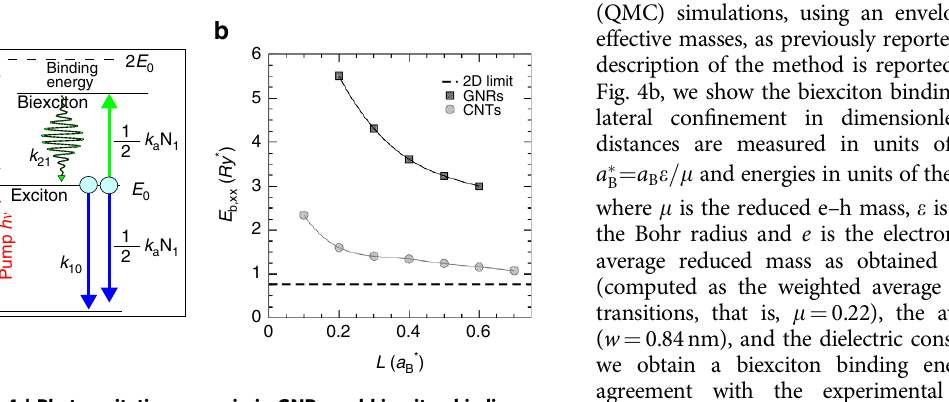
Figure 4 | Photoexcitation scenario in GNRs and biexciton binding energy. ( a ) Sketch of the energetic levels and the kinetic model described in the text. ( b ) Biexciton (XX) binding energy ( E b,XX ) as a function of the lateral dimension ( L ), that is, width for GNRs (black squares) and diameter for SWNTs (grey circles). The data, obtained by guide-function QMC simulations, are shown in dimensionless exciton units, as detailed in the text. In these units, the binding energy of the 4CNR is B 3.4 Ry *. The dashed line indicates the two-dimensional value of E b,XX ¼ 0.77 Ry